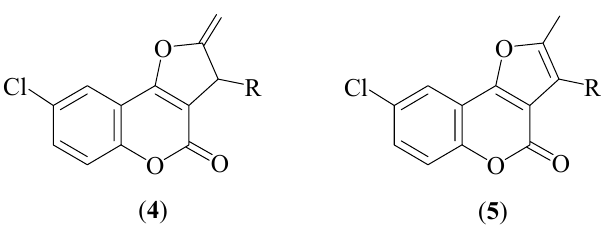
Figure 2. Structures of compounds 4 and 5